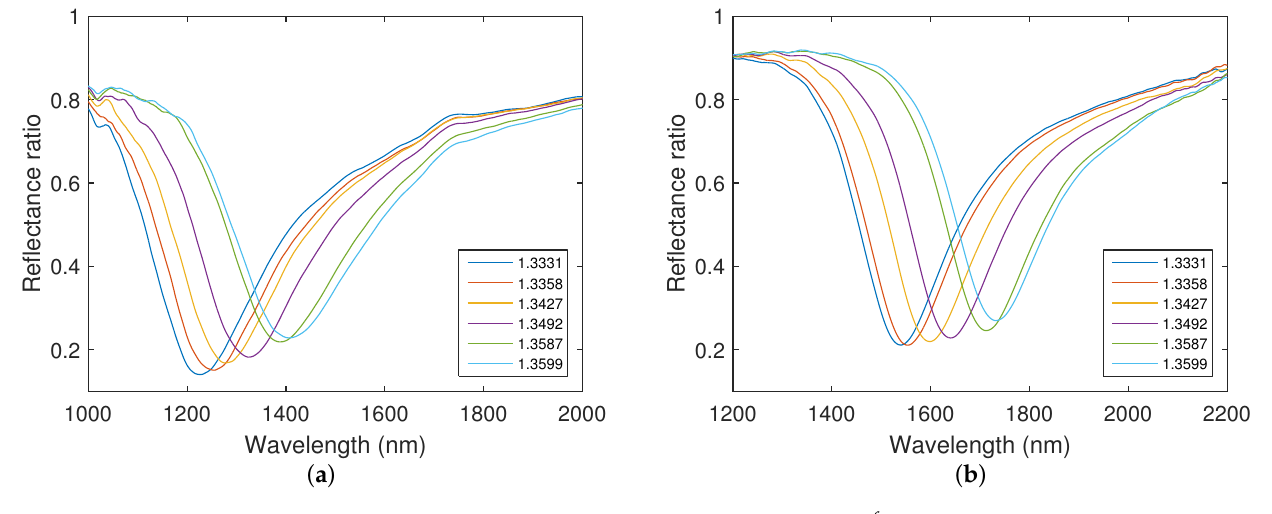
Figure 9. Measured spectral reflectance ratios R p ( λ ) / R ref s ( λ ) for the silicon dioxide layer thicknesses: = 147.5 nm ( a ), t = 270.9 nm ( b ). The angle of incidence θ ≈ 70.2 ◦ . t SiO SiO 2 2